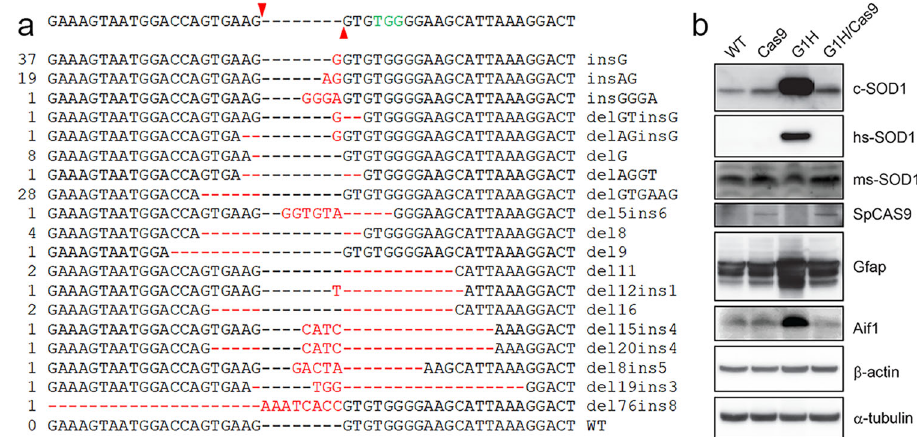
Fig. 3 Ef fi cient targeting of hSOD1 in the G1H/Cas9 mice. a Targeting events identi fi ed in a G1H/Cas9 mouse (#8190, 585 days). Among 112 individual clones analyzed, 19 different targeting events were identi fi ed. PAM sequence (TGG) is labeled in green. Red arrowheads indicate the Cas9 cleavage site. The deleted nucleotides are shown by red dashed lines. Red letters represent the inserted nucleotides. The number of clones harboring the indicated mutation is shown on the left. Individual mutations are on the right. For deletions exceeding six nucleotides, the deleted nucleotides are represented by numbers for clarity. b Ef fi cient removal of hSOD1 in the G1H/Cas9 mice. Immunoblotting of the spinal cord homogenates from mice was performed with antibodies indicated on the right. β -actin and α -tubulin were used as internal loading